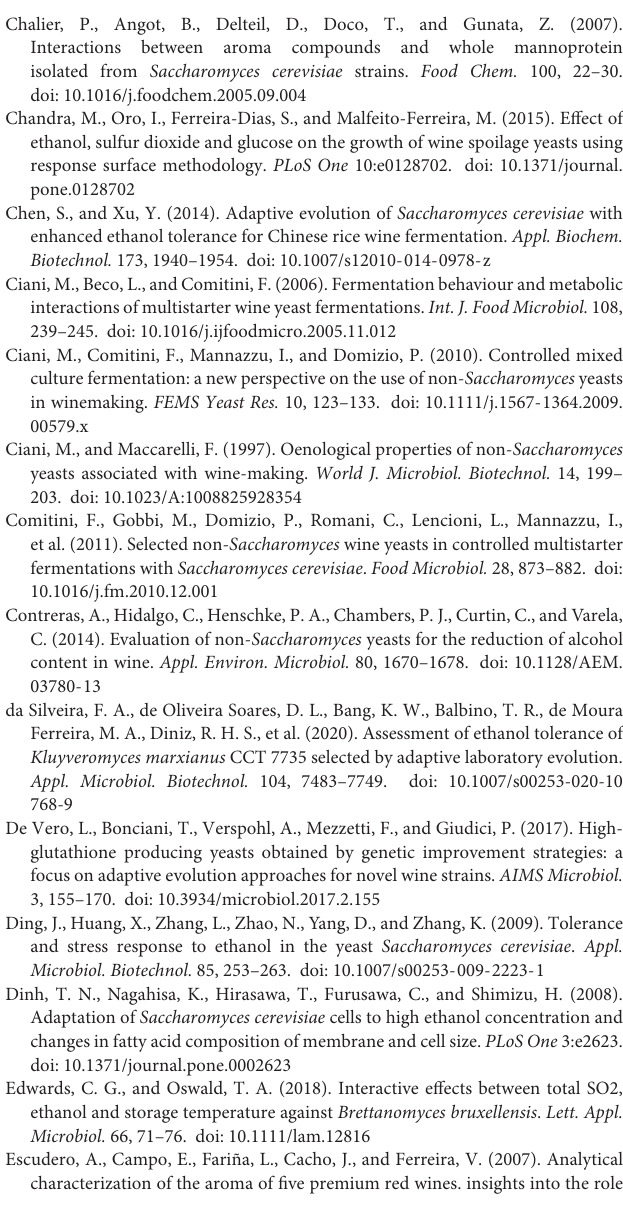
Supplementary Table 1 | Volatile composition (mg/L) of the final wines after alcoholic fermentation. FSc, S. cerevisiae EC1118 pure fermentation; FTd/Sc, co-inoculated fermentation of EC1118 and YCPUC10; FTdF/Sc, co-inoculated fermentation of EC1118 and YCPUC10-F. Mean ± SD ( n = 3). Different letters after means represent significant differences among yeast combinations for fermentation in each parameter (LSD, p ≤ 0.05). Aroma compounds that OAV exceeding one are highlighted and those compounds that OAV exceeding 0.1 but < 1 are